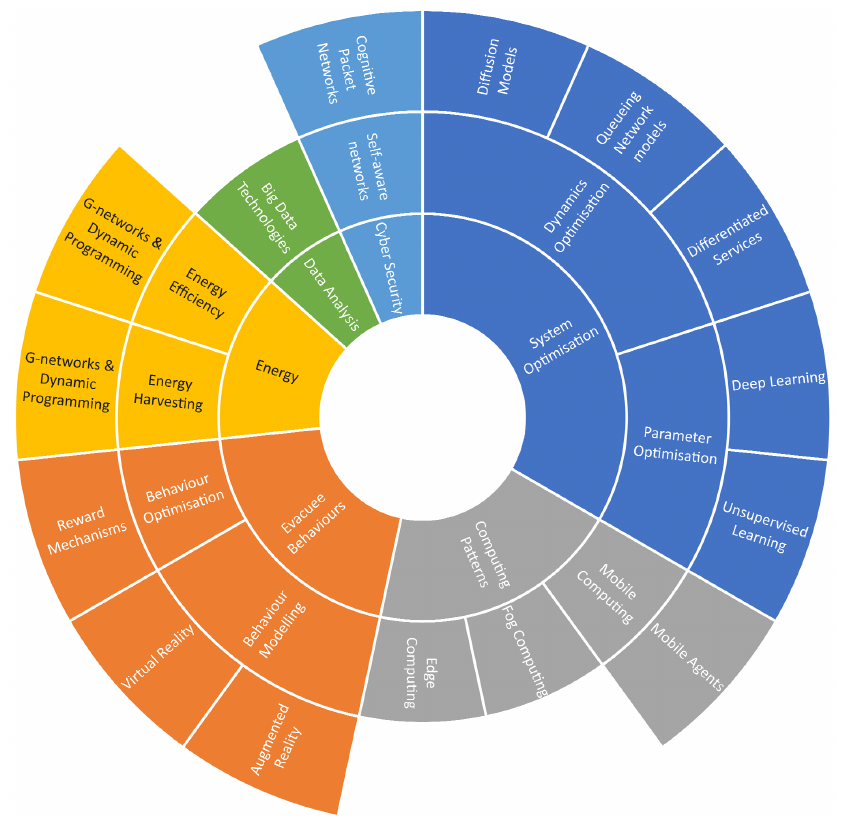
Figure 2. A sunburst chart illustrating the potential research directions. The sunburst chart summarises the potential research directions from the system design, computing pattern, energy utilisation, behaviour modelling and optimisation, data analysis and cyber-security